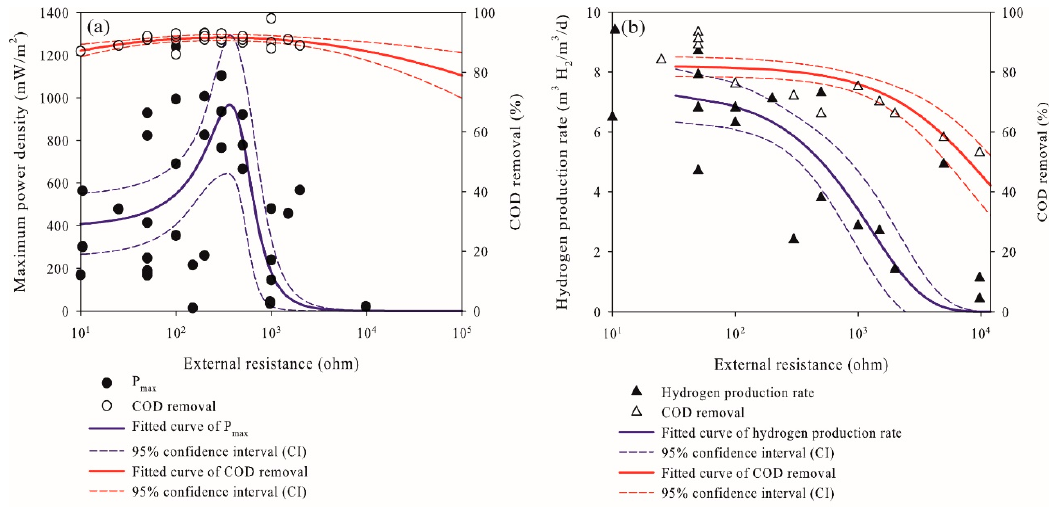
Figure 4. Influences of external resistance on ( a ) MFCs’ power generation and COD removal and ( b ) MECs’ hydrogen production and COD removal. MECs’ hydrogen production and COD